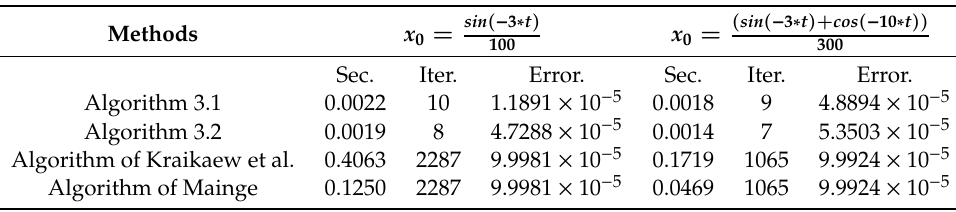
Table 1. Numerical results obtained by other